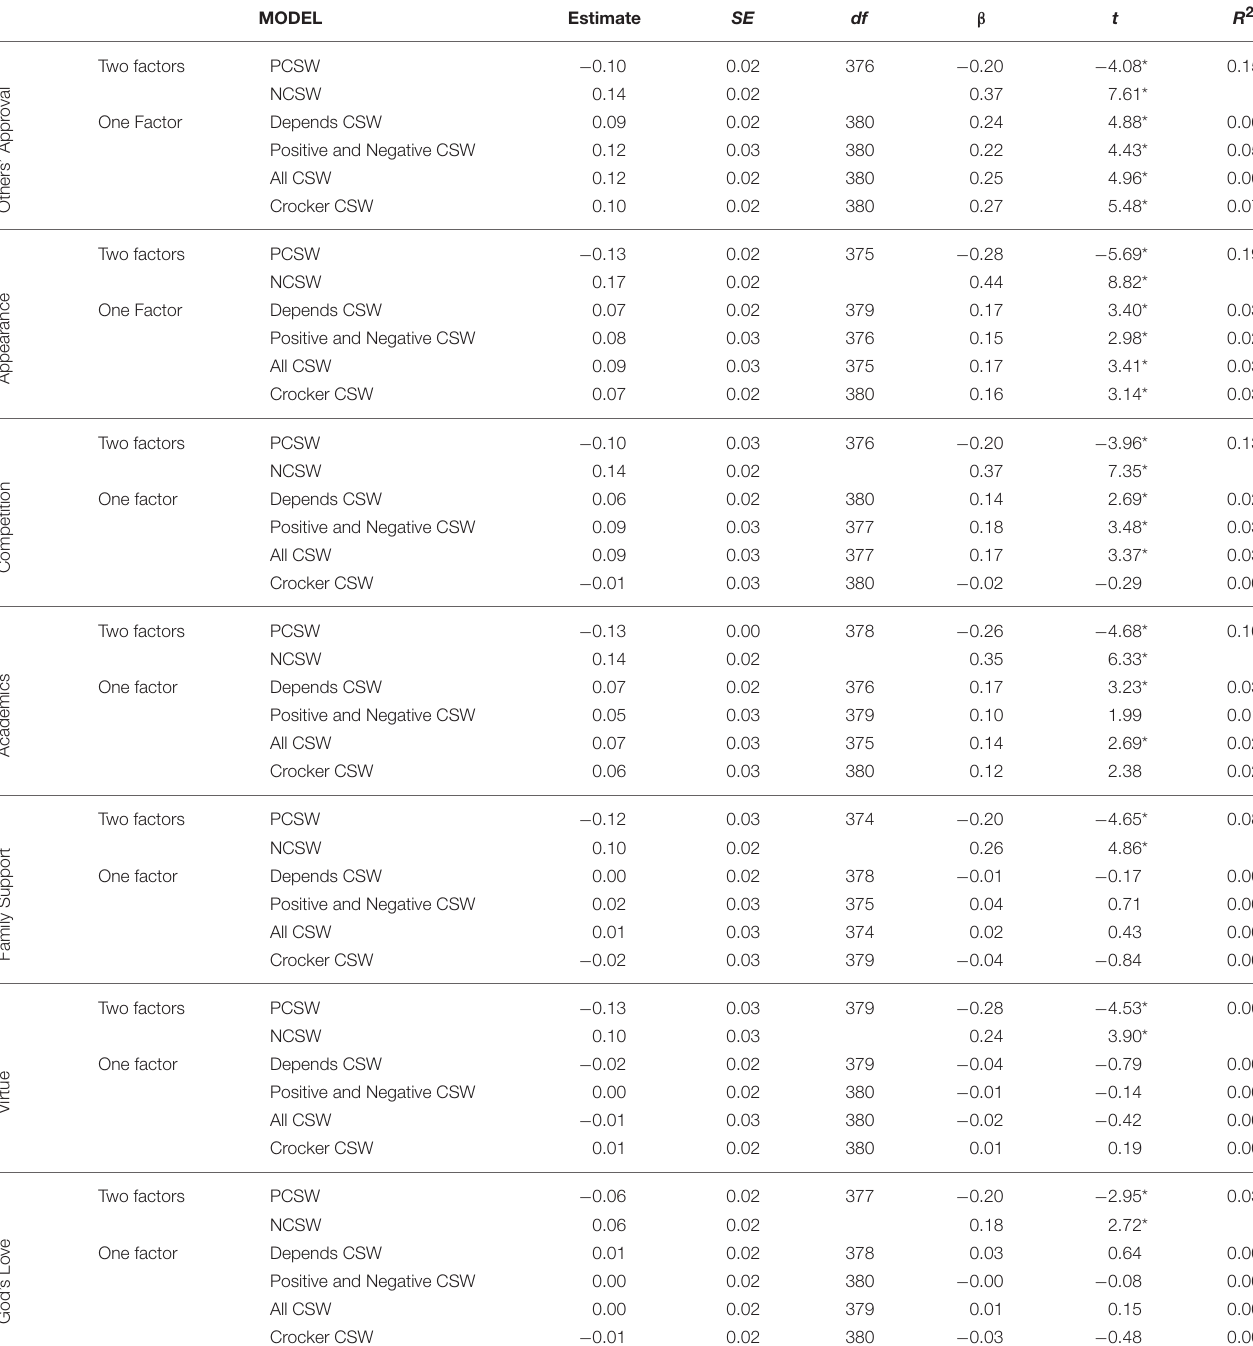
TABLE 3 | Regression Results of the Two- and One-Dimensional CSW on Depression in Seven Domains. MODEL Estimate SE df β t R